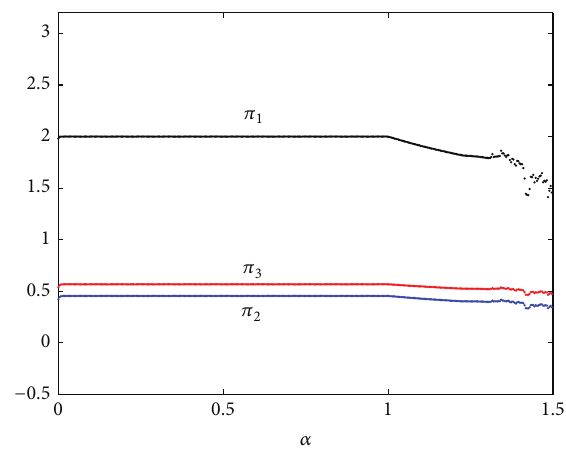
Figure 3: Bifurcation diagram and the Largest Lyapunov exponent ofthediscretedynamicsystem(7)for 𝛼 = 0.5 , 𝛾 = 0.2 ,and 𝛽 varying from 0 to 0.34.